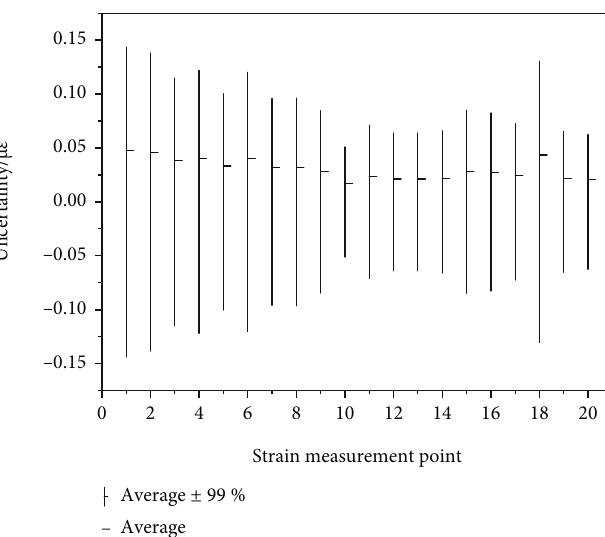
Figure 10: Expanded uncertainty of all the strain